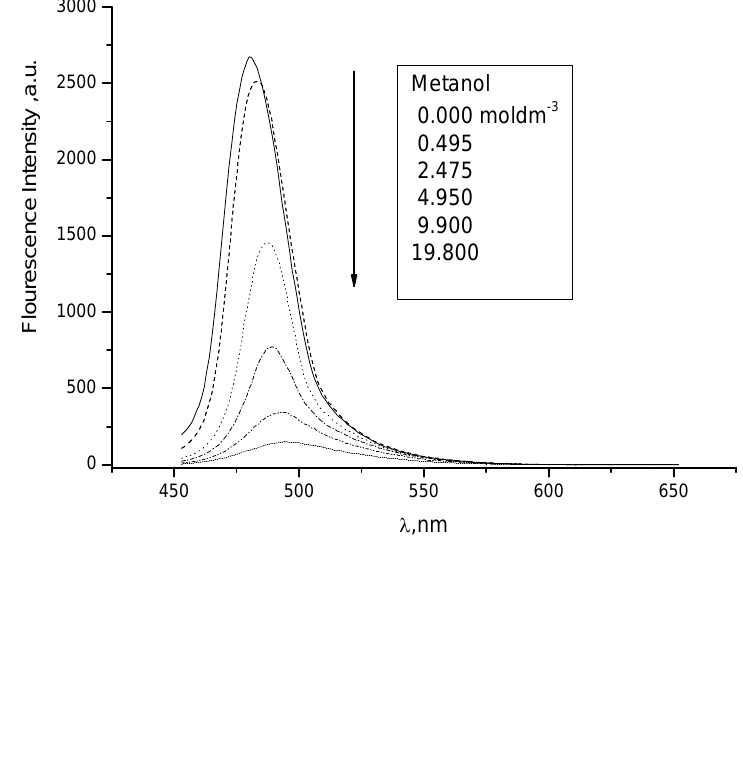
Figure 12. Quenching of fluorescence of 1 in chloroform by polar methanol (0, 0.1, 0.5, 1, 2, 4